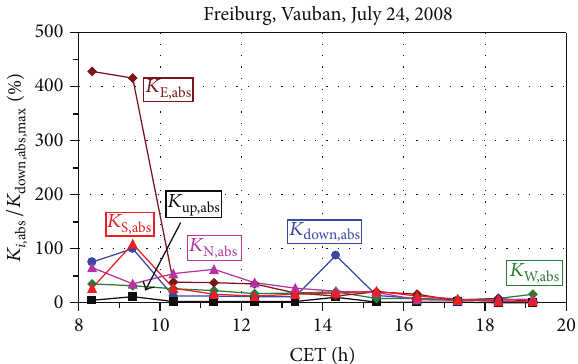
Figure 15: 1h mean values of air temperature 𝑇 𝑎 , mean radiant , and physiologically equivalent temperature PET, temperature 𝑇 mrt SSW-facing sidewalk (shaded by tree canopies) of a WNW-ESE street canyon, “Vauban” quarter in Freiburg during typical Central European summer day.